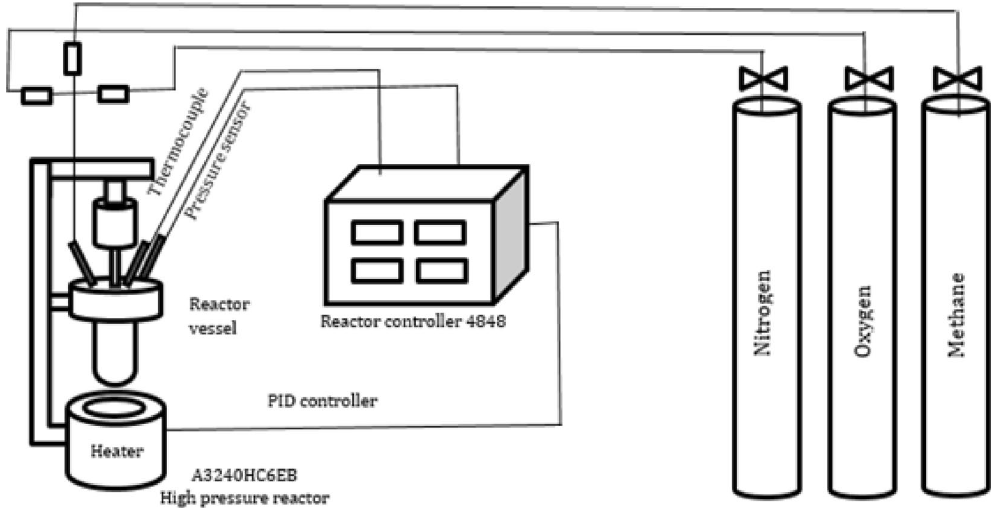
Figure 1. High-pressure reactor and setup design equipped with Parr 4848 reactor